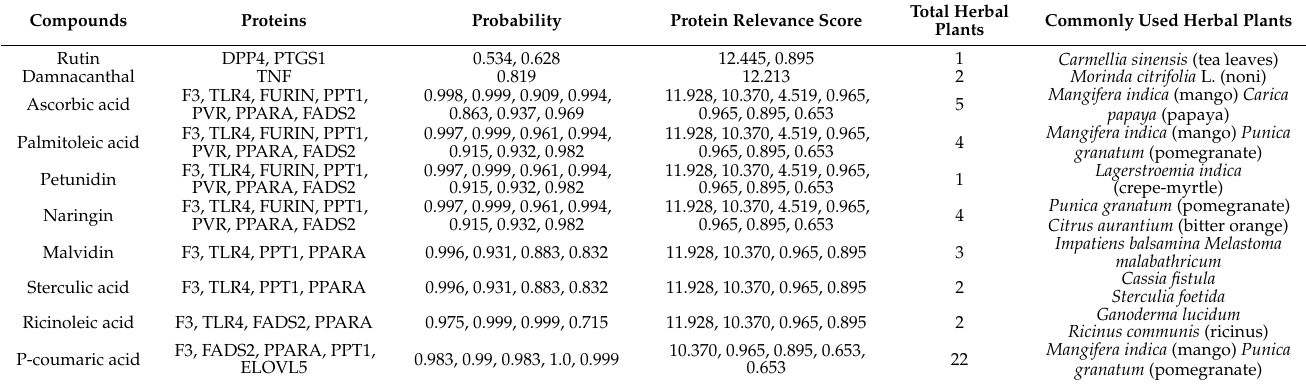
Table 4. Ten compound-protein interactions with the highest protein relevance score of SAE-DNN prediction results with circular fingerprint dataset.